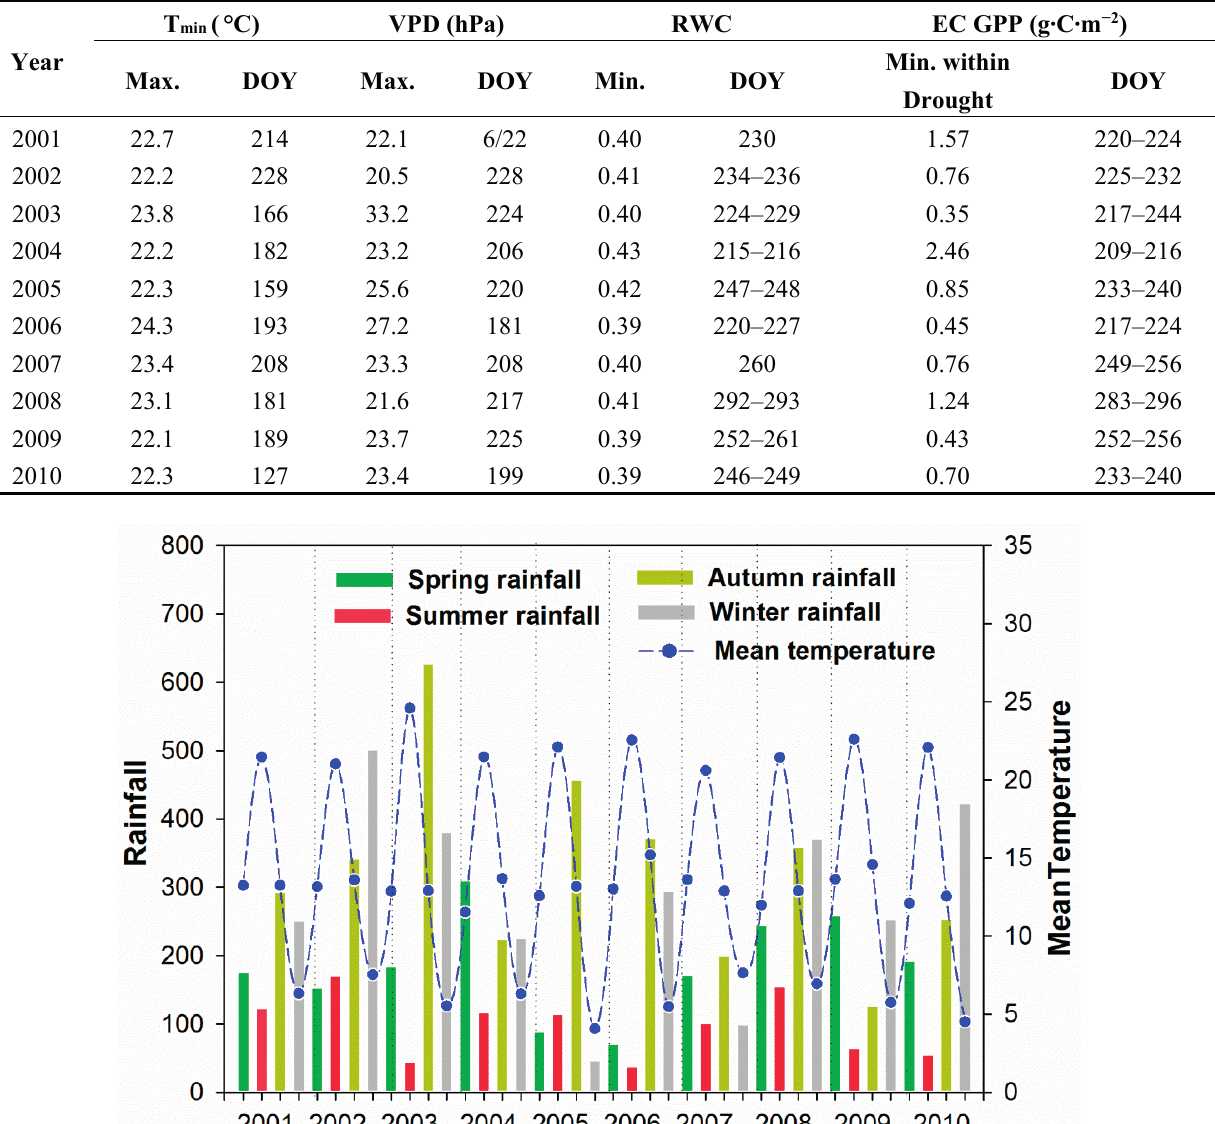
Table A3. Comparison of seasonal timing (day of the year) of the daily minimum temperature (T min ), daily vapor pressure deficit (VPD), daily relative water content (RWC) and tower GPP from 2001 to 2010.